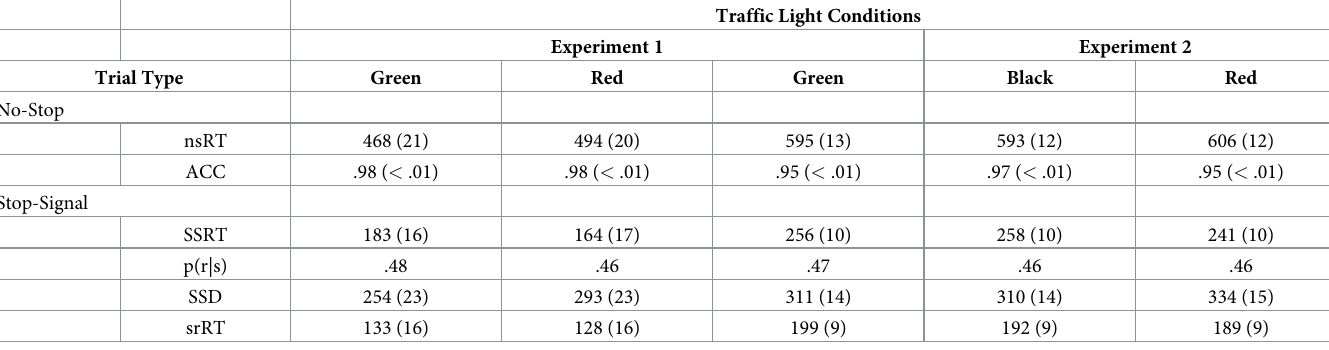
Table 1. Results of the different traffic light conditions in no-stop-signal and stop-signal